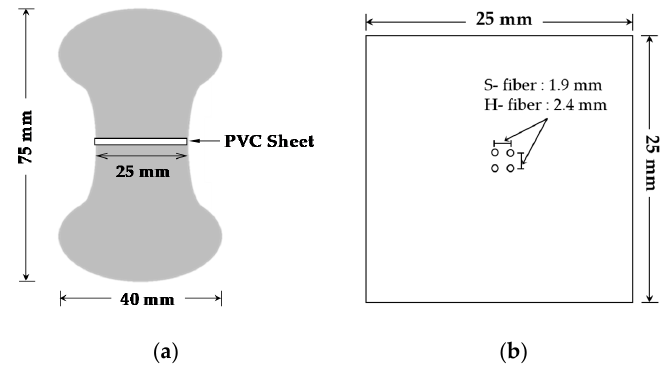
Figure 1. ( a ) Dimensions of the dog-bone specimen and ( b ) cross sectional details. Table 1. Compositions and properties of cementitious materials.